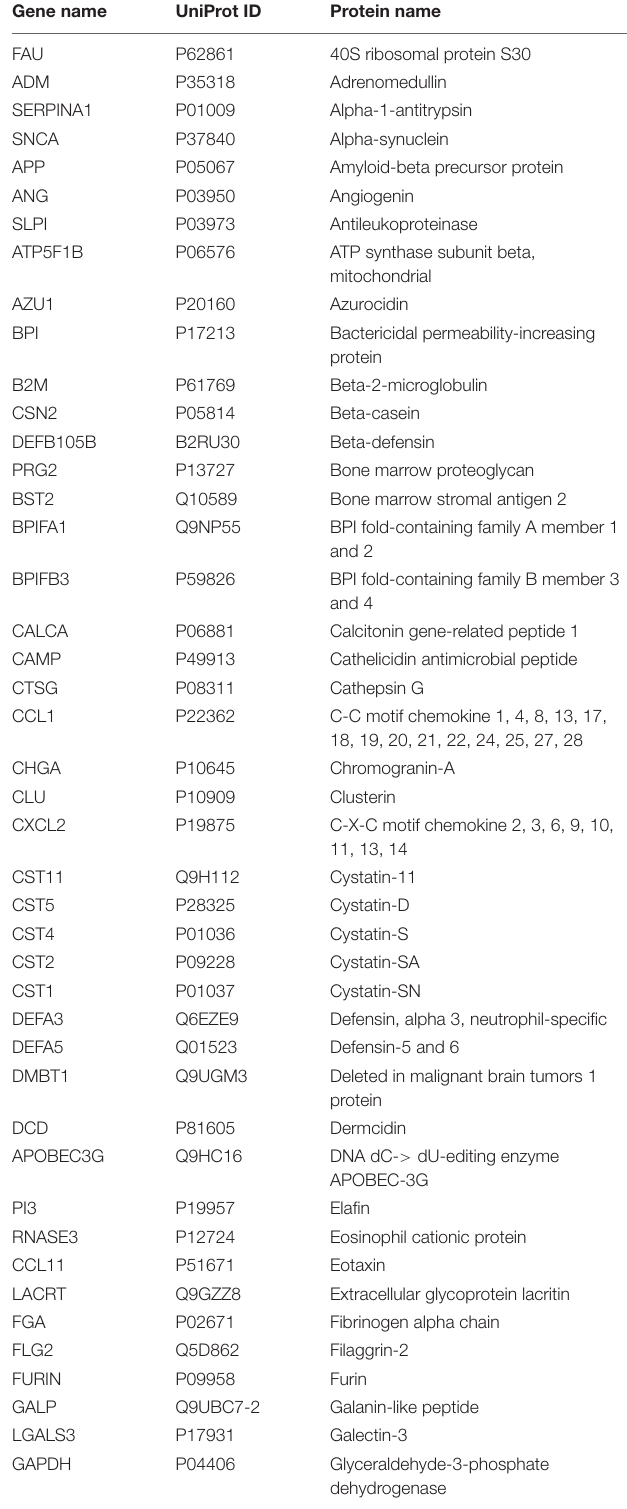
TABLE 2 | Antimicrobial and immunomodulatory proteins listed in the comprehensive human antimicrobial immunomodulatory peptide (UDAMP)